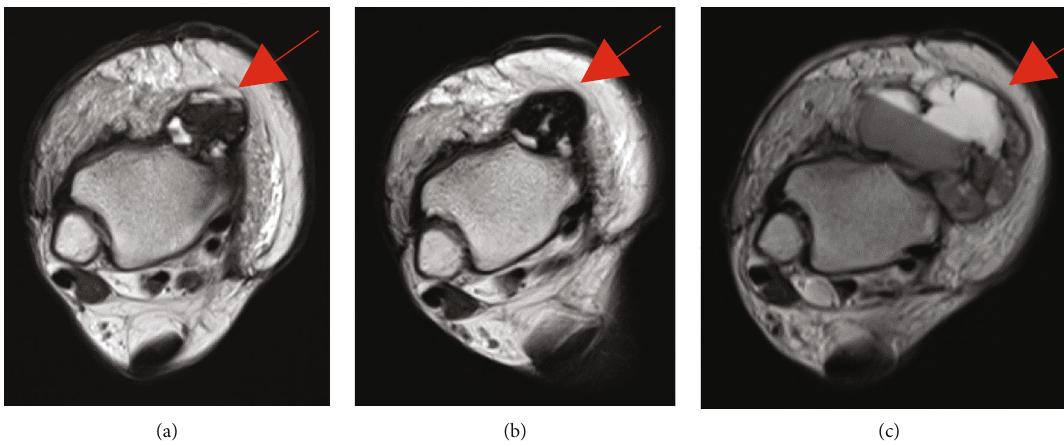
Figure 3: Tumor progression of the local recurrent tumor during tocilizumab treatment. (a) Axial image of the recurrence tumor in the ankle region acquired using T2-weighted MRI at the time of recurrence. (b) Axial image of the recurrence tumor in the ankle region acquired using T2-weighted MRI 2 months after starting on tocilizumab treatment. (c) Axial image of the recurrence tumor in the ankle region acquired using T2-weighted MRI 4 months after the fi rst evaluation. The tumor is indicated by the arrows in red.